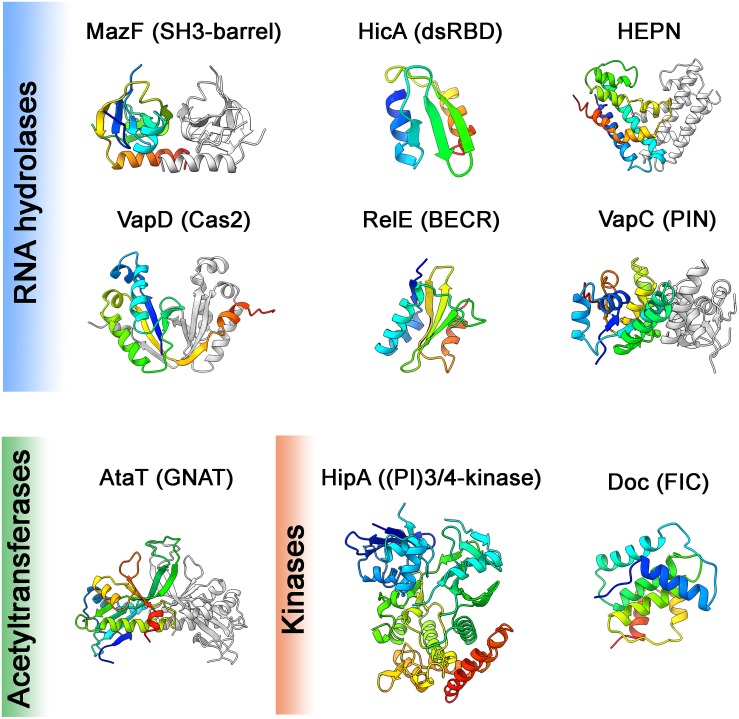
Toxin structures. Structures of the toxins from different families representing different structural folds (noted in brackets) are shown. These domains are common in proteins of the defense and offense systems (HEPN, Cas2, BECR, FIC), RNA processing (dsRBD, PIN), eukaryotic cell signaling (SH3-barrel, (PI)3/4-kinase) or various other functions (GNAT). Structures are colored in rainbow from N-terminus (blue) to C-terminus (red), in cases of dimers the second monomer is in gray. Structures were visualized using ChimeraX, PDB codes were following: E. coli MazF:3nfc; E. coli HicAB:6hpb (Manav et al., 2019); S. oneidensis SO_3166-SO3165 (HEPN): 5yep (Jia et al., 2018); H. pylori HP0315 (VapD): 3ui3 (Kwon et al., 2012); S. flexneri VapCD7A: 5ecw (Xu et al., 2016); E. coli RelER81A, R83A: 2kc9 (Li et al., 2009); E. coli HipAS150A: 3tpb (Schumacher et al., 2012); E. coli AtaTY144F: 6gtp (Jurenas et al., 2019); prophage P1 Phd-Doc: 3k33 (Garcia-Pino et al., 2010). In the cases of structures in complexes with antitoxin, the coordinates of antitoxin were deleted.